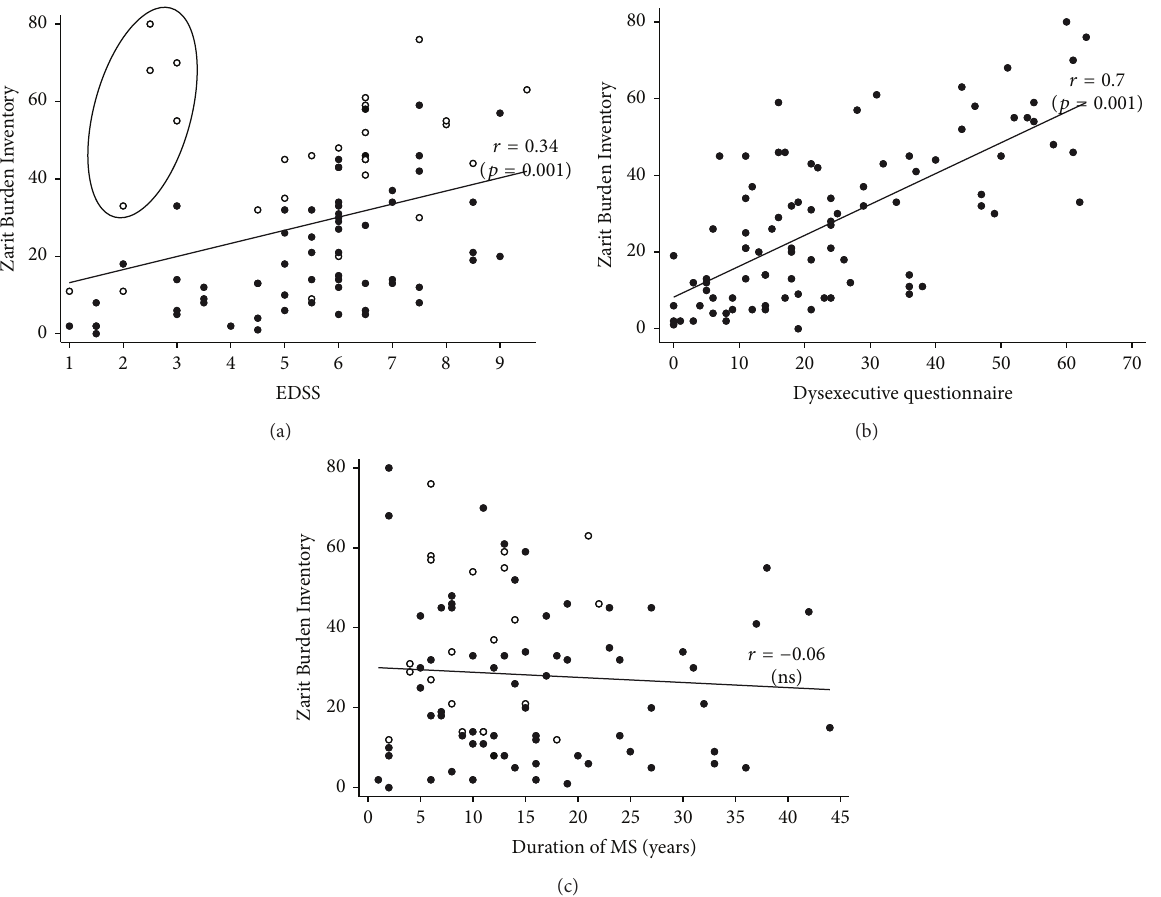
Figure 2: Informal caregiver subjective burden (Zarit Burden Inventory (ZBI)): (a) scatterplots of the correlation between EDSS scores and ZBI scores. White dots signify that patient’s Dysexecutive questionnaire score is over 75th percentile (otherwise dark dots); circle represents patients with EDSS score under 4 and Dysexecutive questionnaire score over the 85th percentile, (b) scatterplots of the correlation between Dysexecutive questionnaire scores and ZBI scores, and (c) scatterplots of the correlation between MS duration and ZBI. White dots specify fast progressors (i.e., patients with a rapid disability course identified in the Multiple Sclerosis Severity Score [9, 13] table over the 8th decile) and dark dots specify